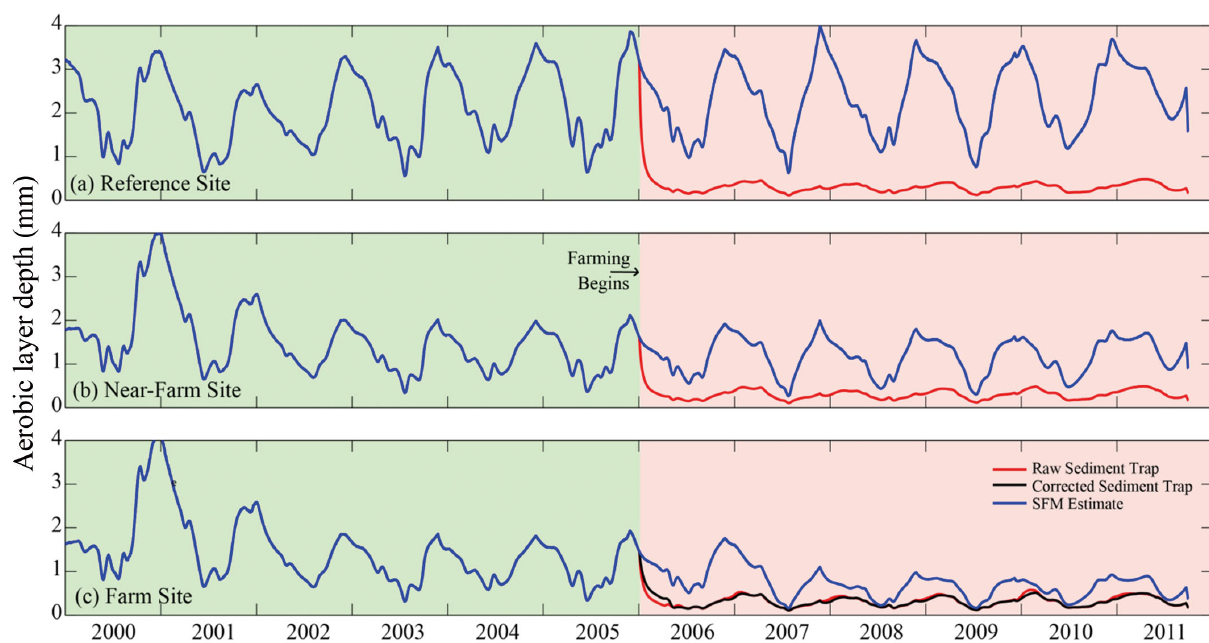
Fig. 8. Time-series (2000−2011) of modeled aerobic-layer depth at (a) reference, (b) near-farm, and (c) farm sites. Green and red shading indicates pre- and post-oyster farming periods, respectively. Red line: uncorrected raw sediment trap simulation at the farm site, black line: farm site sediment trap estimates corrected for resuspension, blue line: simulation where deposition was estimated by sediment flux model (SFM) by fitting deposition to the observed sediment–water NH 4+ fluxes